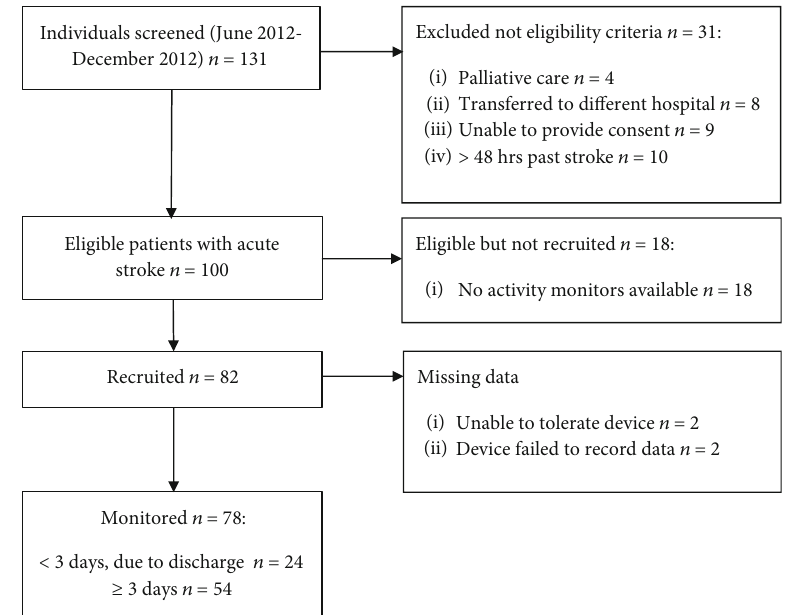
Figure 1: Flow diagram of screened and included acute stroke